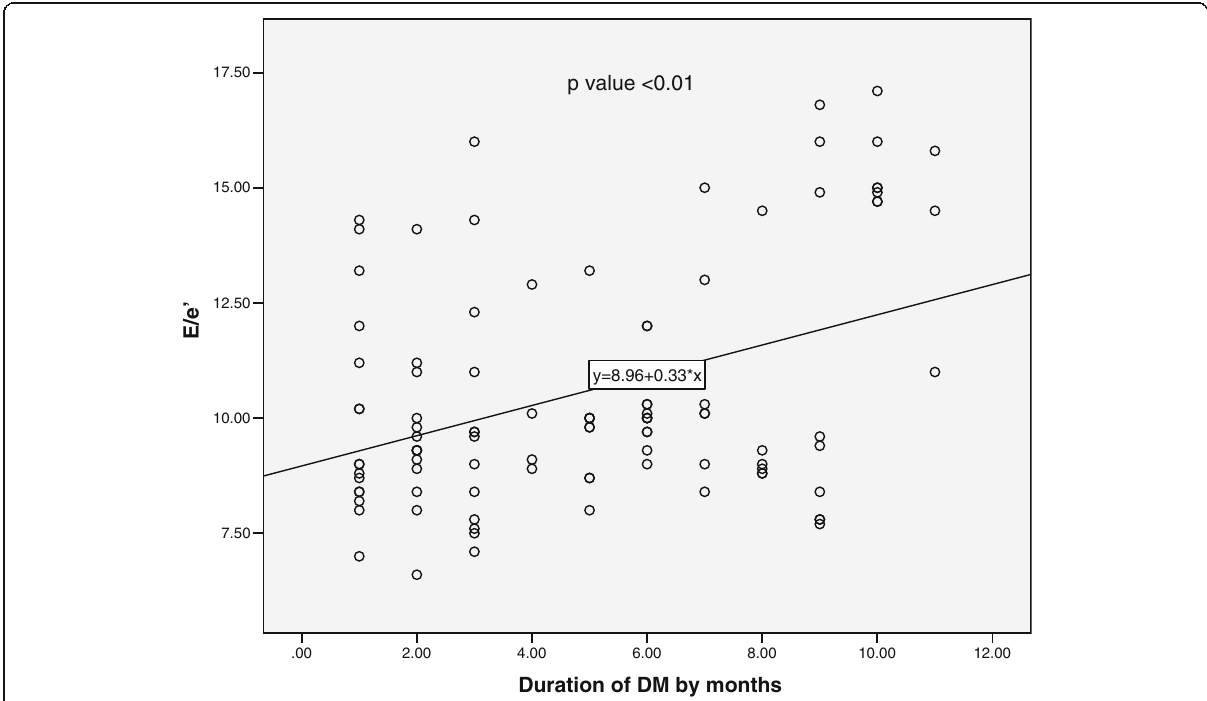
Fig. 2 Correlation between diastolic function and duration of diabetes mellitus